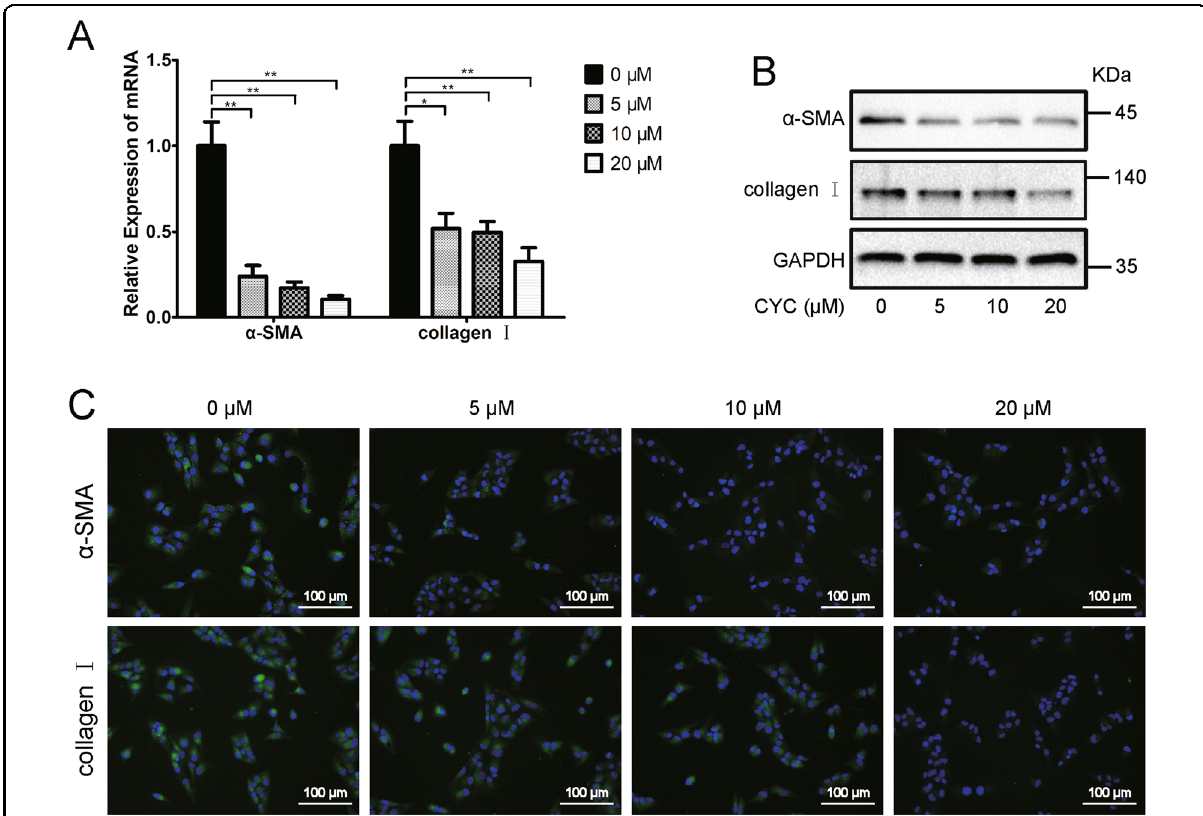
Fig. 5 Downregulation of SMO reduced fi brosis markers. A The relative mRNA level of fi brosis markers α -SMA and collagen I after CYC treated in WPMY-1. B The relative protein level of fi brosis markers α -SMA and collagen I after CYC treated in WPMY-1. C Immuno fl uorescence staining of α -SMA (green) and collagen I (green) in WPMY-1 after CYC treated. * p < 0.05, ** p < 0.01; one-way ANOVA. The scale bars are 100 μ